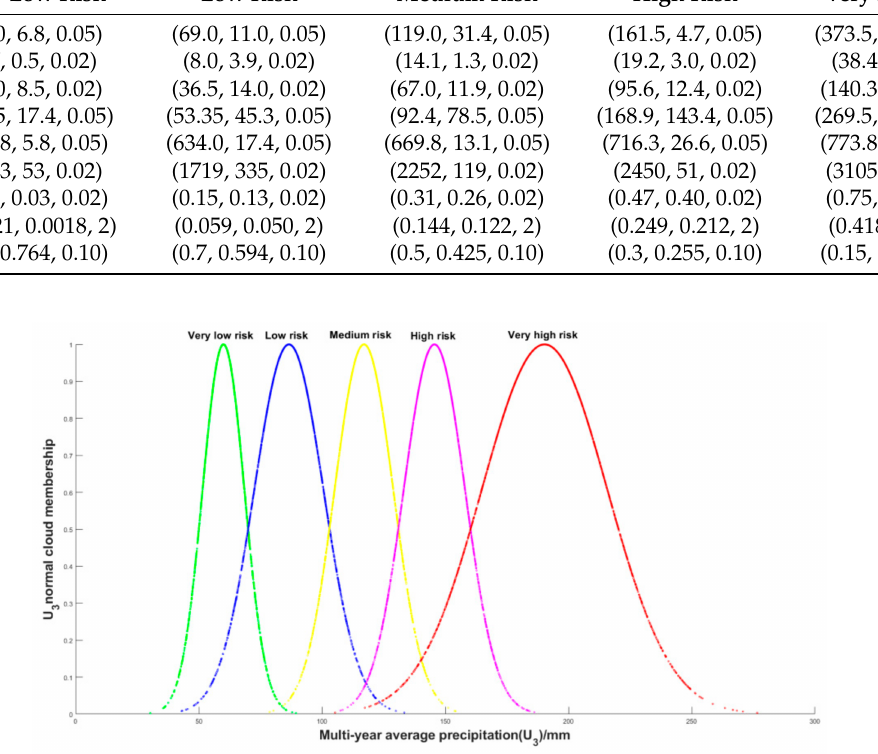
Figure 5. Hazard factor U 3 normal cloud membership